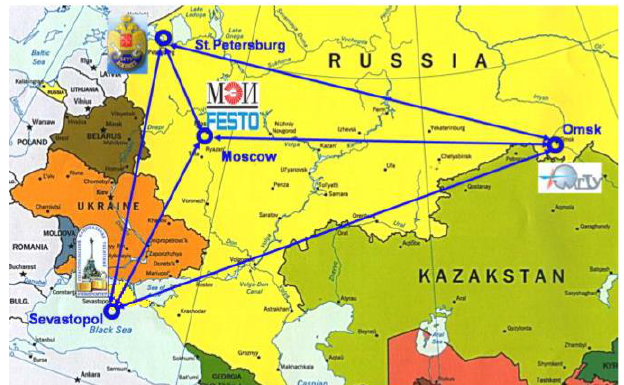
Figure 1. A map of interaction between